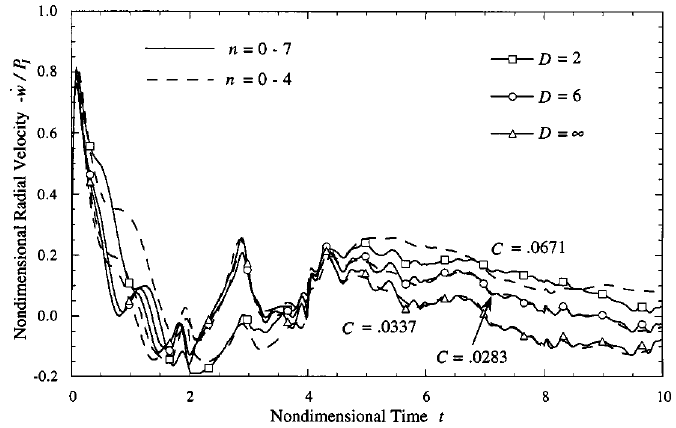
Fig. 10. Shell radial-velocity histories at (cid:18) = (cid:25) for a filled spherical shell excited by spherical step-exponential waves ( (cid:12) =